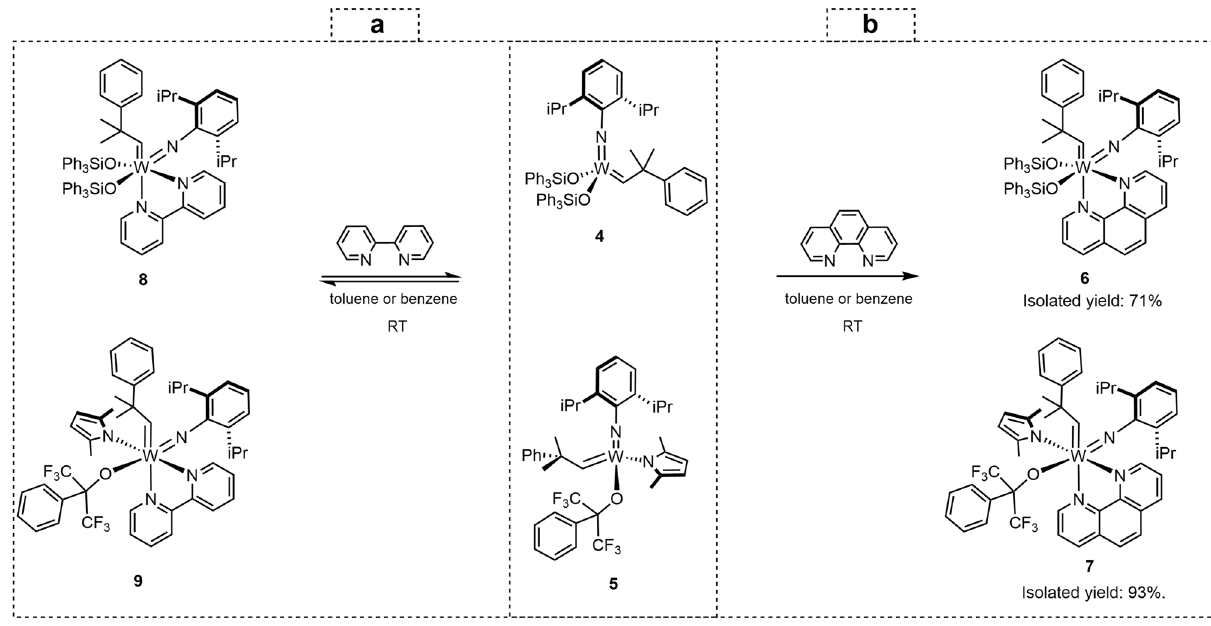
Fig. 2 Reactions of W(VI)-disiloxide catalyst 4 and W(VI) MAP catalyst 5 with 1,10-phenanthroline and 2,2 ′ -bipyridine. Both 4 and 5 react with 1,10- phenanthroline quantitatively and irreversibly ( b ), while their reactions with 2,2 ’ -bipyridine are reversible, lead to equilibrium mixtures ( a